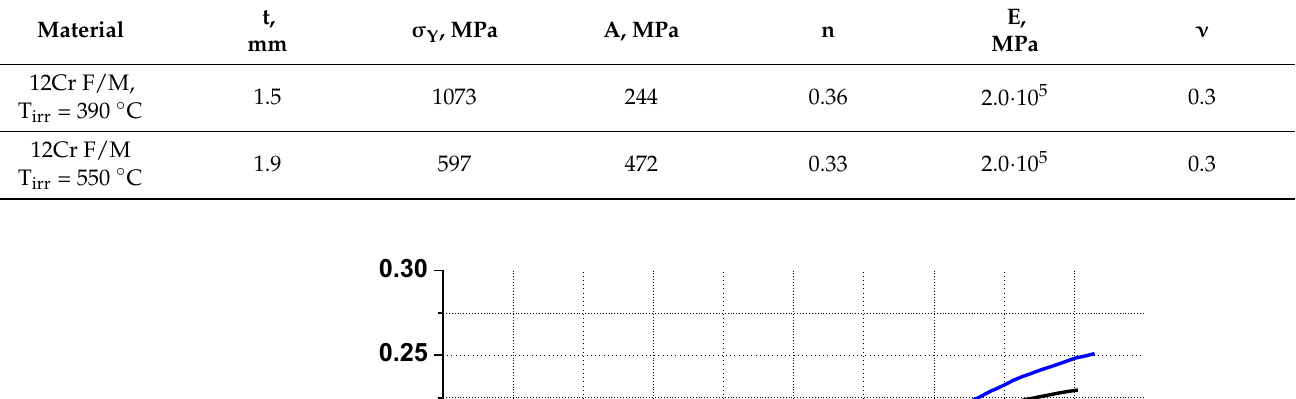
Table 6. The values t, σ Y , A, n, E, and ν used for FEM calculations at T = 20 ◦ C.